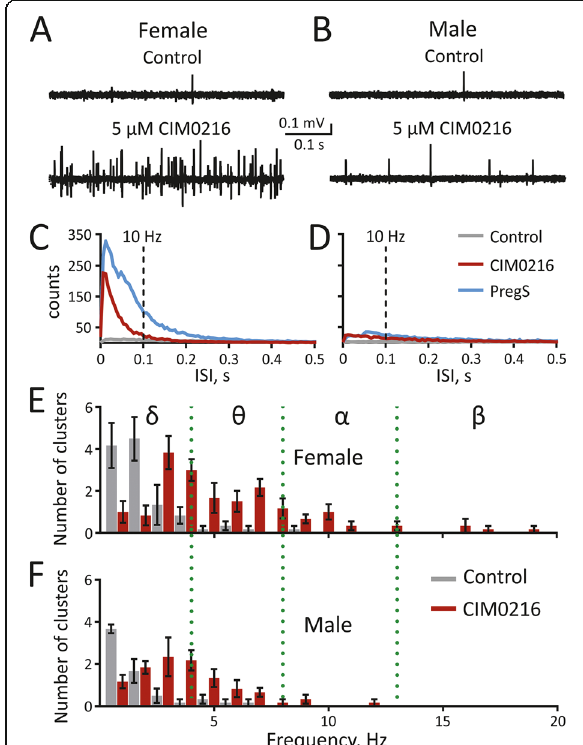
Fig. 6 Spectral analysis of nociceptive firing in control conditions and the presence of CIM0216. ( A, B ) Example traces of MUA within one experiment in the control condition and during 5 μ M CIM0216 in females ( A ) and males ( B ). Notice, there is only a single spike in the control condition in both males and females, while during the 2-min active phase of 5 μ M CIM0216 application, the number of spikes increased differently for females and males, within the initial 0.5-s of drug application. (C, D) Spectrograms show the average interspike intervals (ISI) for all experiments in females ( C ) in the control conditions (grey line, n = 13), after application of 50 μ M PregS (blue line, n = 7) and after 5 μ M CIM0216 application (red line, n = 6) and in males ( D ) in the control condition (grey line, n = 11), after application of 50 μ M PregS (blue line, n = 5) and after 5 μ M CIM0216 application (red line, n = 6) on panel. The dotted vertical line at 0.1 ISI indicates the 10 Hz frequency. The number of ISIs below 0.1 s (i.e. reflecting spiking activity above 10 Hz frequency) is higher in females after 50 μ M PregS and 5 μ M CIM0216. ( E, F ) Distribution of fibres (clusters) according to the firing frequency in the control condition (top panel; grey) and after application of 5 μ M CIM0216 (bottom panel; red) presented as mean ± SEM for females ( E ) ( n = 6) and males ( F ) ( n = 6) on panel ( F ). Notice that 5 μ M CIM0216 induced nociceptive firing with θ -range of spiking activity for both sexes, whereas in females, θ -range, as well as higher spiking activity of α and β -ranges, were